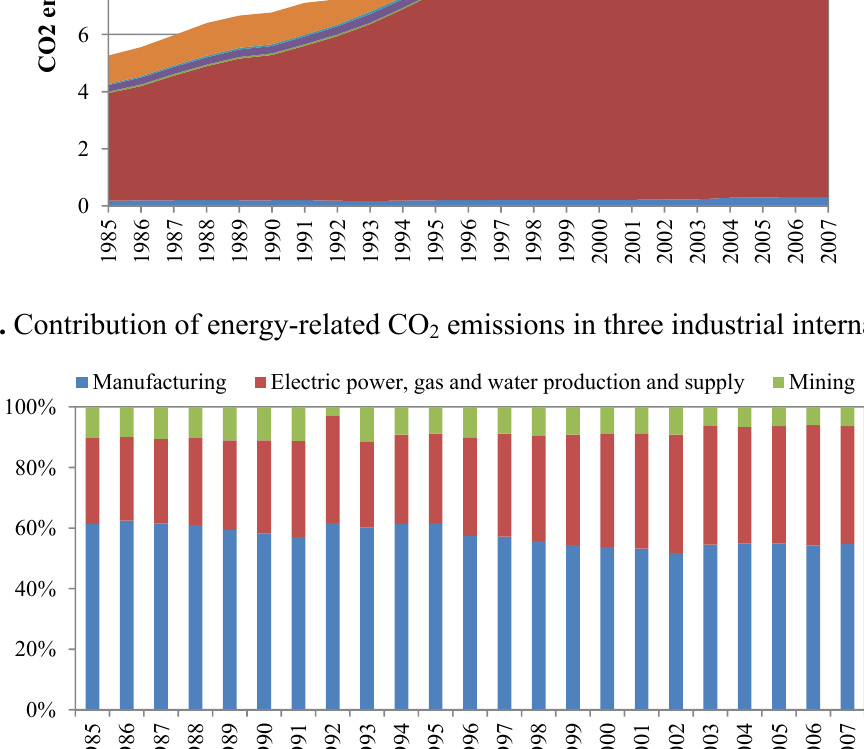
emissions in three industrial internal sectors.